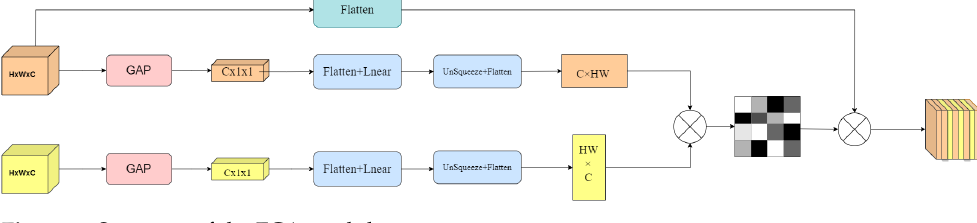
Figure 6. Structure of the FCA